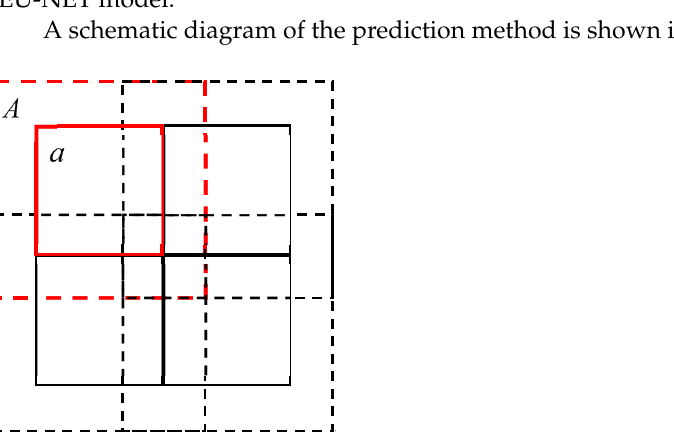
Figure 11. Diagram of prediction method. The size of A should be consistent with the size of the sample image, which is 256 × 256 pixels in this paper.